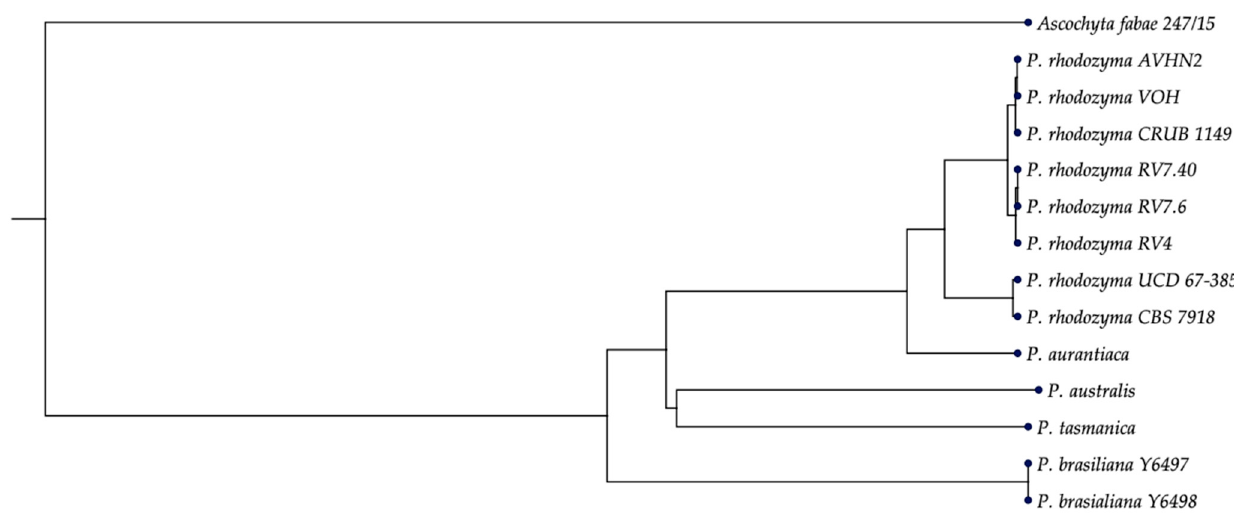
Figure 8. Phylogenetic placement of Phaffia species based on a combined alignment of the MYC cluster containing the structural genes controlling the mycosporine biosynthesis pathway and the two regulatory intergenic regions, IGR1 / IGR2 . Maximum Likelihood Phylogeny 1.3. UPGMA, Kimura 80 model construction, and bootstrap analysis with 1000 replicates were performed with CLC Genomics Workbench 22.0.2 software. Ascochyta fabae was used to root the tree.